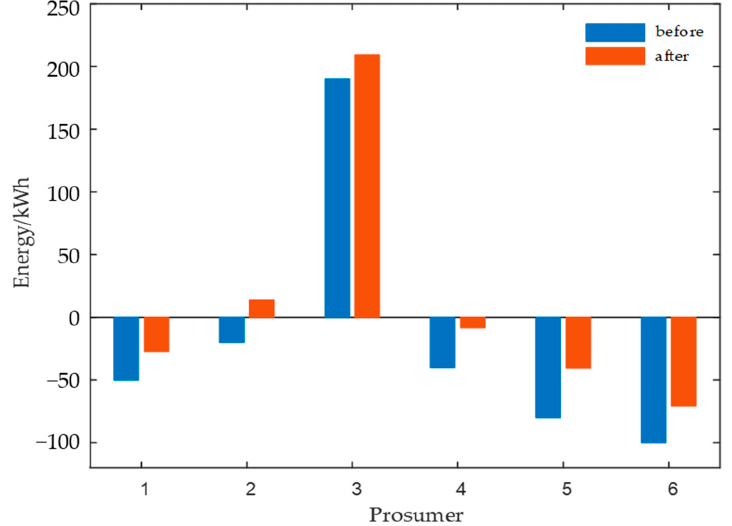
Figure 8. The comparison of renewable energy sources’ (RES) generation and load demand before and after enrolling in energy sharing mechanism (ESM).